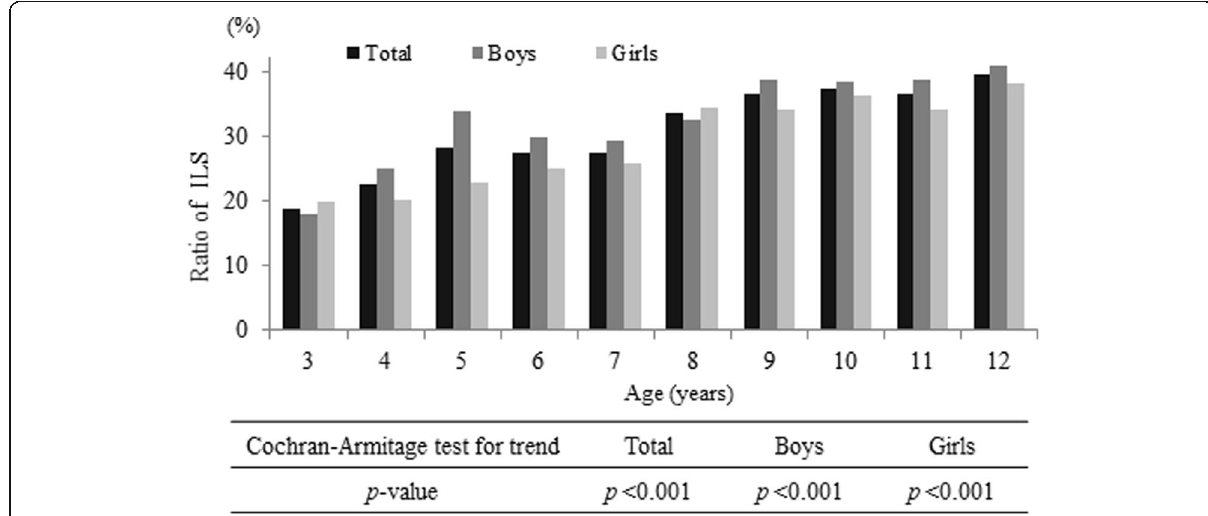
Fig. 3 The age-dependent rate of incompetent lip seal (ILS) in Japanese children (%). An incompetent lip seal was defined as an answer of “ yes ” or “ think so ” to question item 18 —“ Is your child ’ s mouth often open during the day?